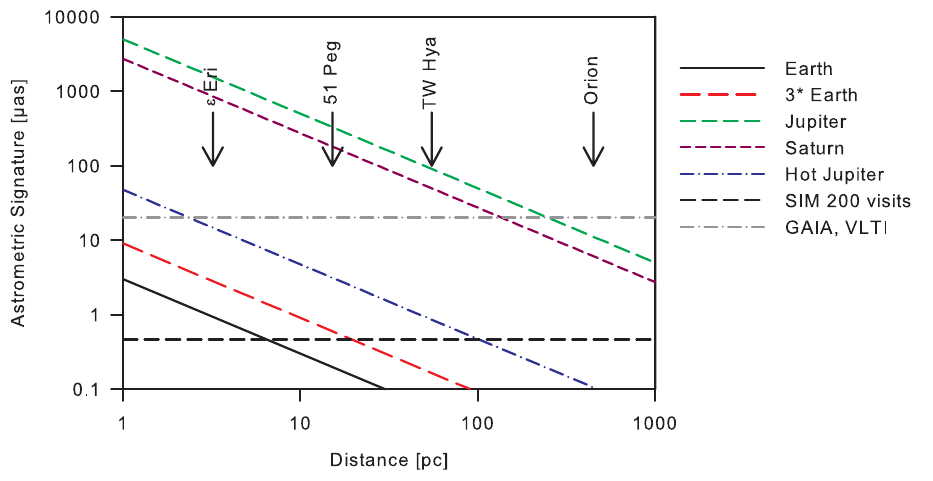
Figure 2. Astrometric signature (semi-amplitude) for five sample planets orbiting a Solar-mass star. Distances of a few benchmark objects are marked with arrows. Anticipated detection limits for ground-based (VLTI PRIMA) and space-based (Space Interferometry Mission) instruments are shown with horizontal lines. Adopted from Quirrenbach